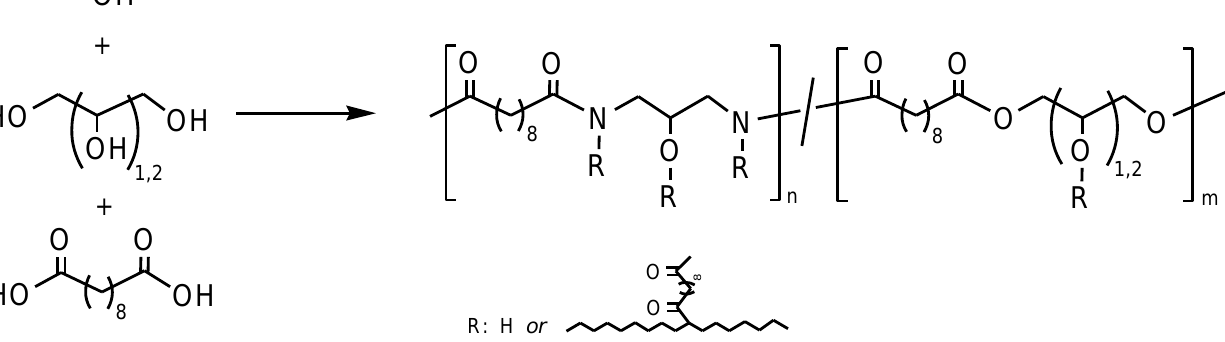
Figure 26. Synthesis of elastomers based on a multifunctional amine group (e.g., 1,3-diamino-2-hydroxypropane), a polyol (glycerol or D,L-threitol) and dicarboxylic acids (e.g., sebacic